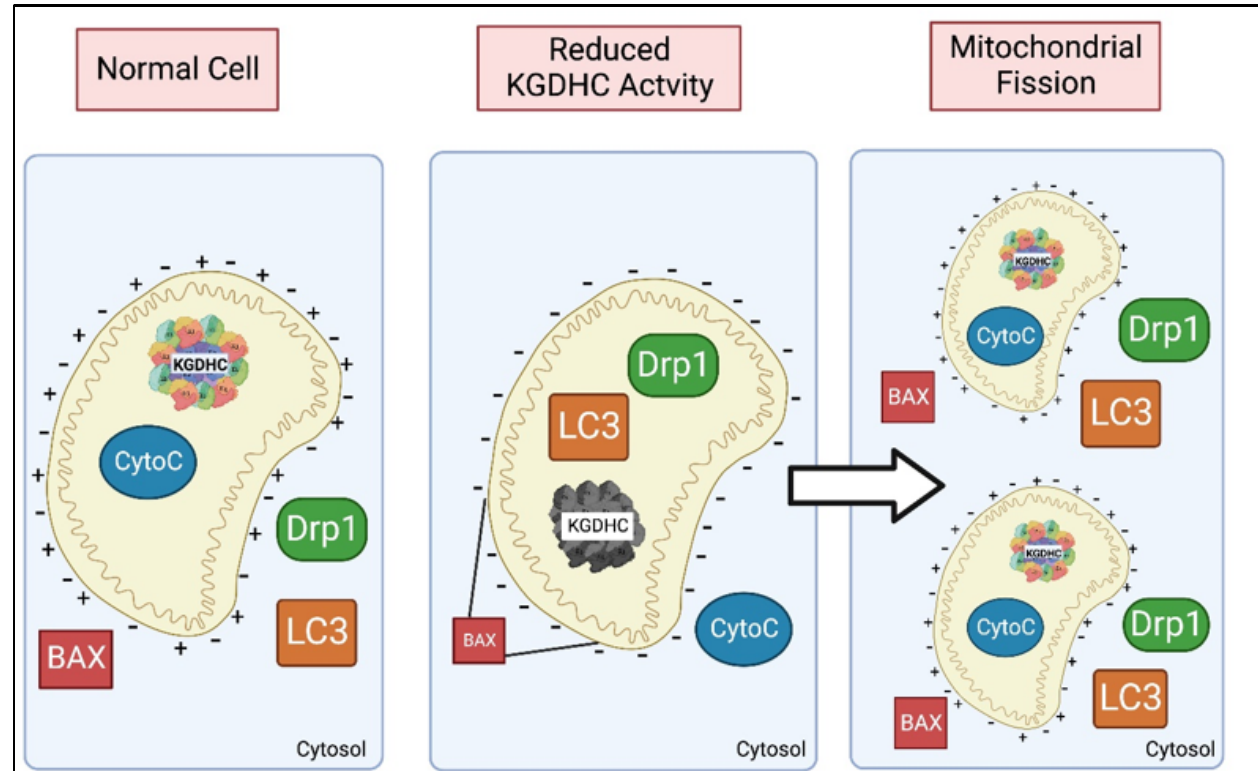
Figure 10. α -ketoglutarate dehydrogenase (KGDHC) and cellular protein signaling. Under normal conditions, Dynamin-related Protein 1 (Drp1) is present in the cytosol and cytochrome C is localized to the mitochondria. Inhibition of KGDHC results in Drp1 entering the mitochondria and cytochrome C translocating into the cytosol. The presence of Drp1 inside the mitochondria leads to the fission of the mitochondria. For cytochrome C to leave the mitochondria, Bcl-2 Associated X-protein Bax needs to be bound, but Bax needs a certain amount of mitochondrial membrane length to bind. Therefore, the fission of the mitochondria leads to less cytochrome C release because Bax has less room to bind. The capability of mitochondria to control complex cellular protein signaling with the cytosol is well documented in regard to apoptosis (for review see [146]). Protein signaling modulates mitochondrial fusion and fission, which are necessary for mitochondrial